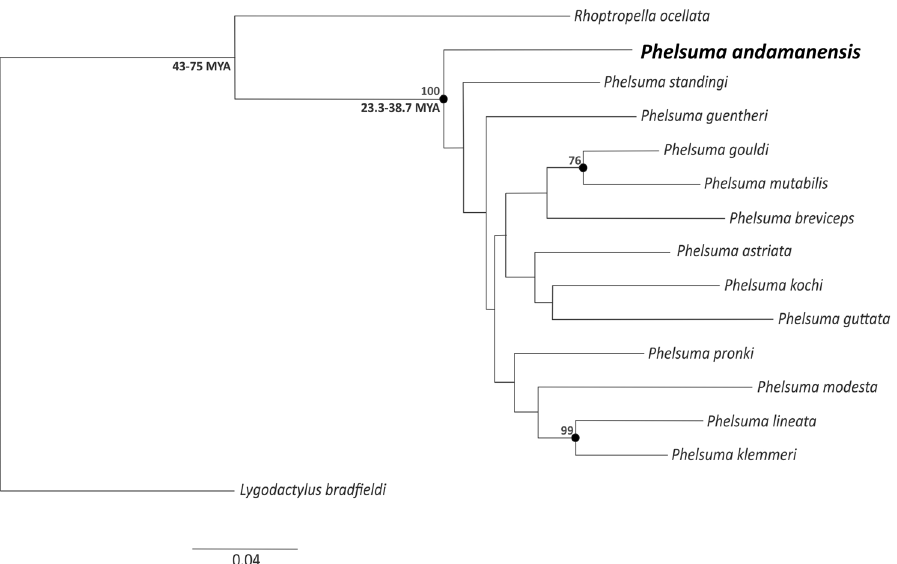
Figure 2. Maximum likelihood analysis of a concatenated alignment of 9,278 bp from 4 mitochondrial and 9 nuclear genes run 10 times, with 10,000 bootstrap replicates each. Black dotted nodes represent Maximum Likelihood (ML) supported nodes with a support above 70% (other nodes received less support). Numbers at the first two nodes are pairwise divergence time estimates (confidence intervals) obtained from Timetree. org, shown as general indication of the likely time frame of Phelsuma diversification. Figure labelled using CorelDraw Home & Student, X7 (https ://www.corel draw.com).